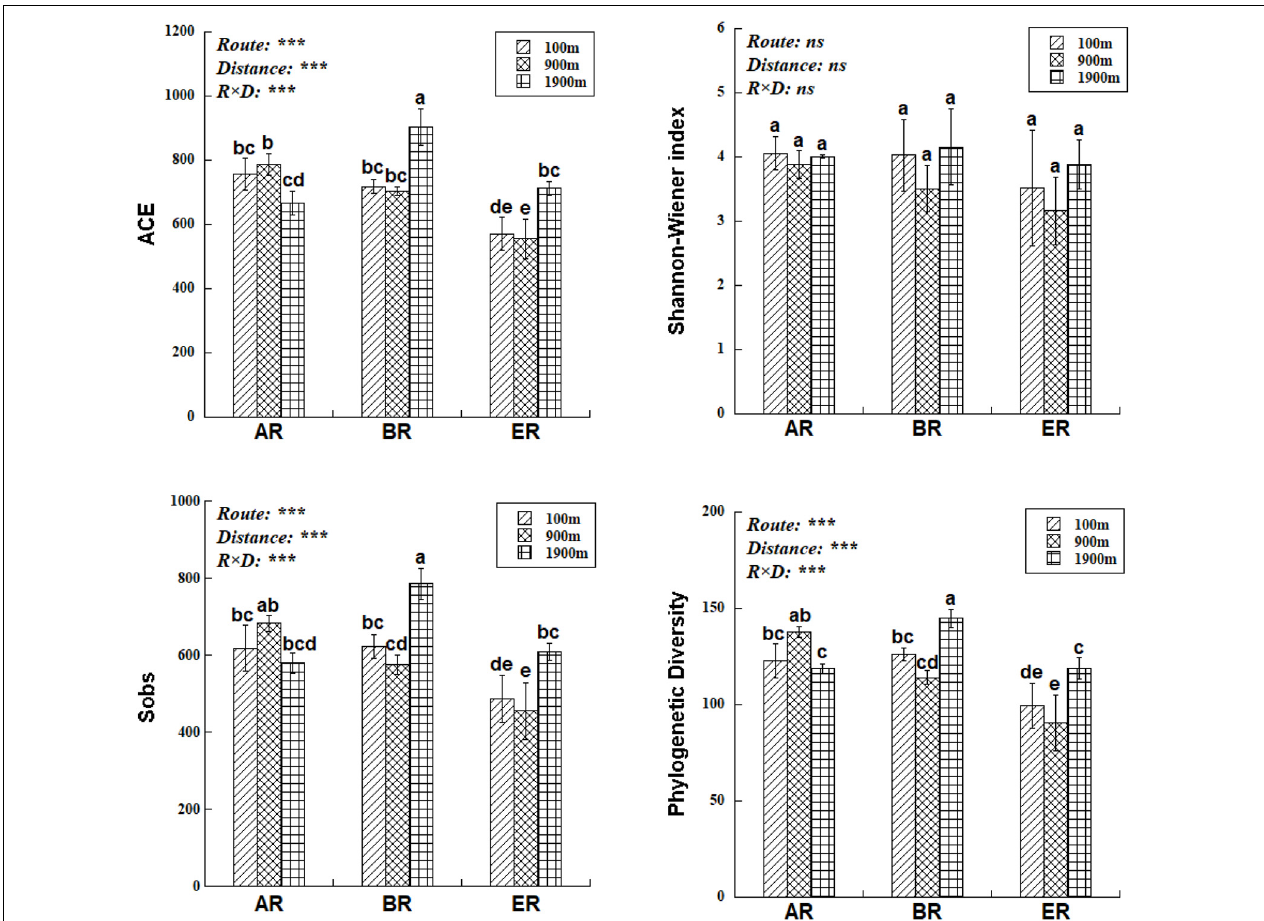
FIGURE 2 | Differences in fungal abundance-based coverage estimate (ACE), number of observed species (Sobs), phylogenetic diversity (PD) and Shannon–Wiener index at different distances and routes. Two-way ANOVA reveals the effect of route (R), distance (D), and their interactions (R × D) on fungal diversity indices (ns, not significant, P ≥ 0.05; *** P < 0.001). Error bars represent standard deviation. Bars followed by lowercase letters are significantly different among distances and routes ( P < 0.05).